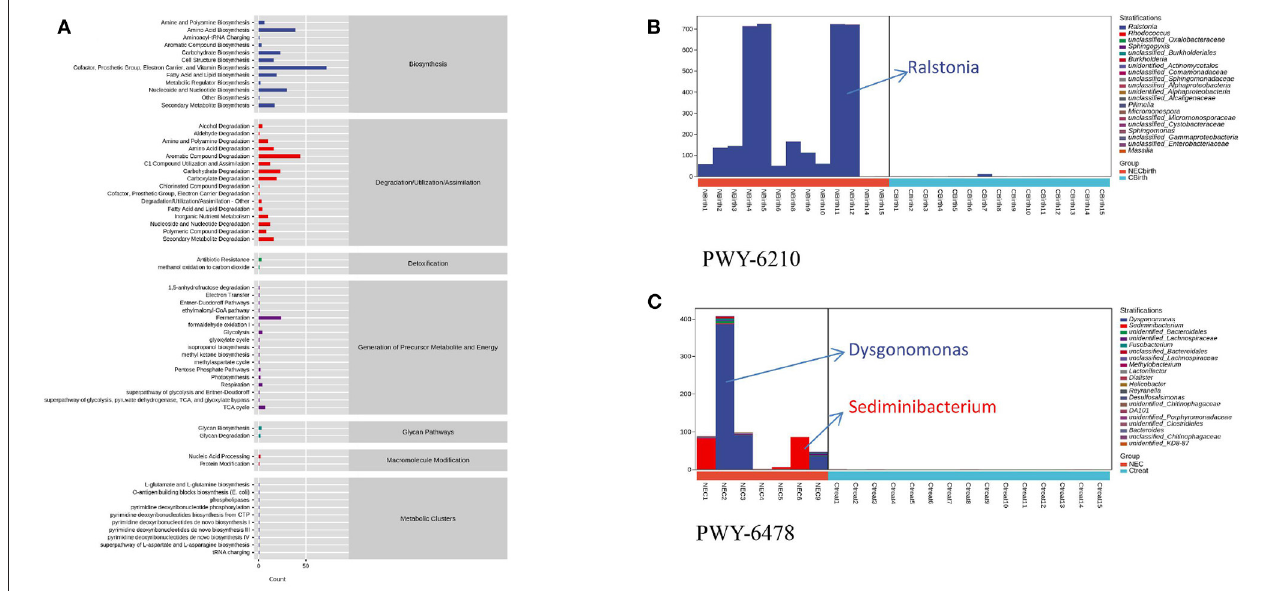
FIGURE 4 | Microbial function prediction. (A) Metabolic pathways involving microbes in all infant feces. (B) PWY-6210 pathway’s species composition. (C) PWY-6478 pathway’s composition of two species. NEC2, NEC3, and NEC9 are infants diagnosed with necrotizing enterocolitis within 20